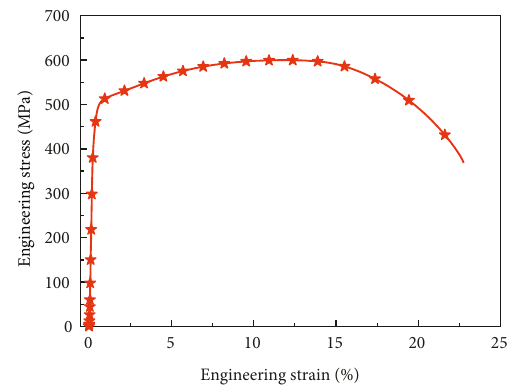
Figure 3: The engineering stress-strain curve of solutions treated